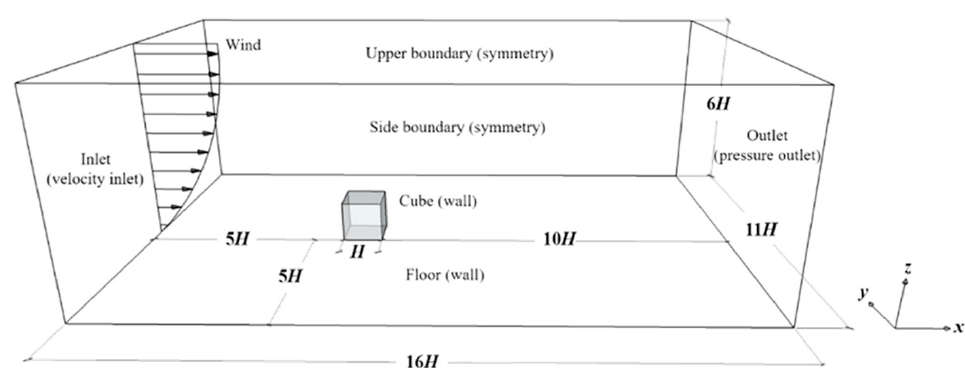
Figure 2. Computational domain and boundary conditions.